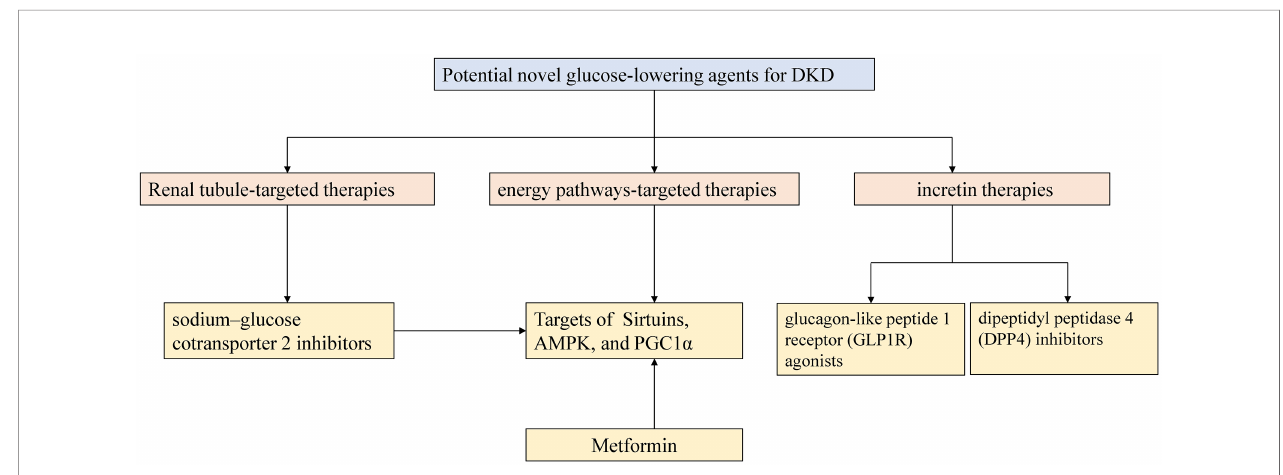
FIGURE 3 | Outlines of potential novel glucose-lowering agents for DKD. AMPK 5-AMP-activated protein kinase; PGC-1 a peroxisome proliferator-activated receptor g coactivator-1